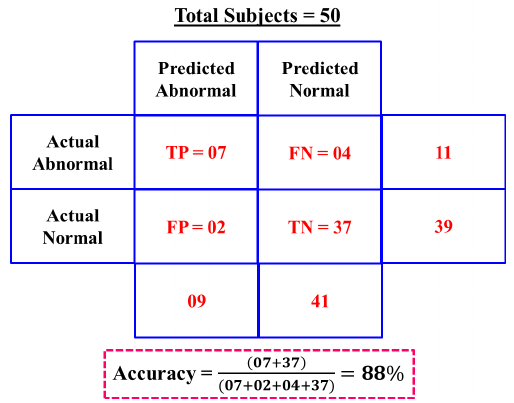
Figure 18. Accuracy result of early warning module.